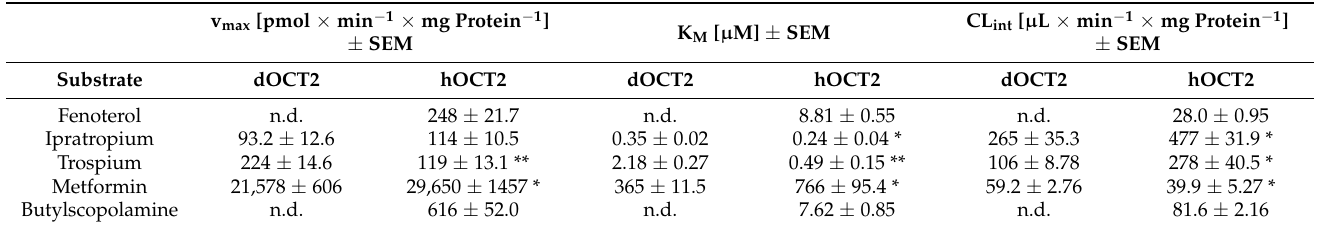
Table 2. Kinetic parameter of OCT2-mediated substrate uptake by dog and human